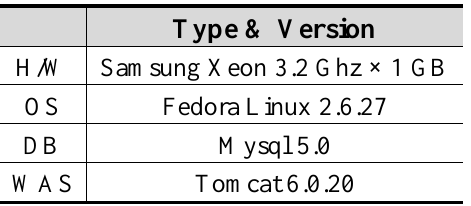
Table 4. Web GUI Development